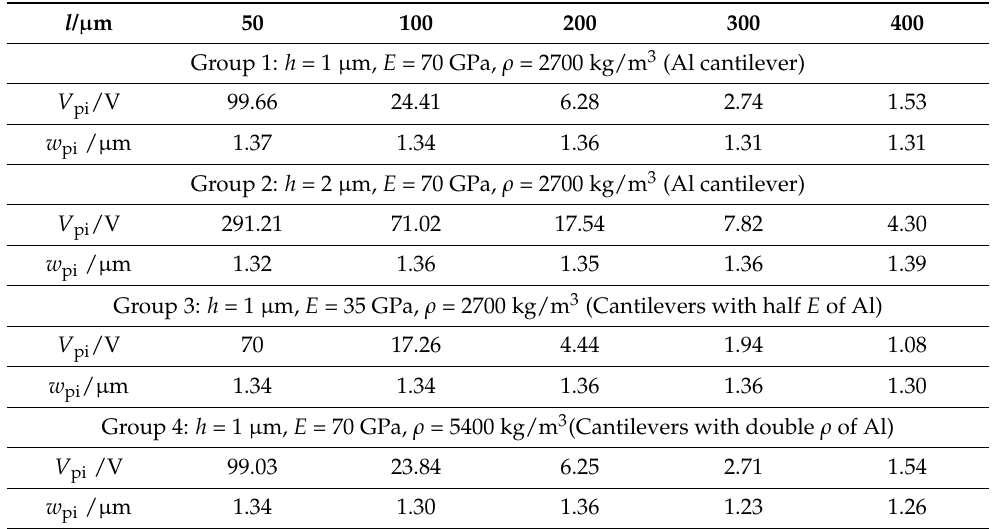
Table 2. Pull-in voltages V pi and displacements w pi of cantilevers for different l , h , E and ρ